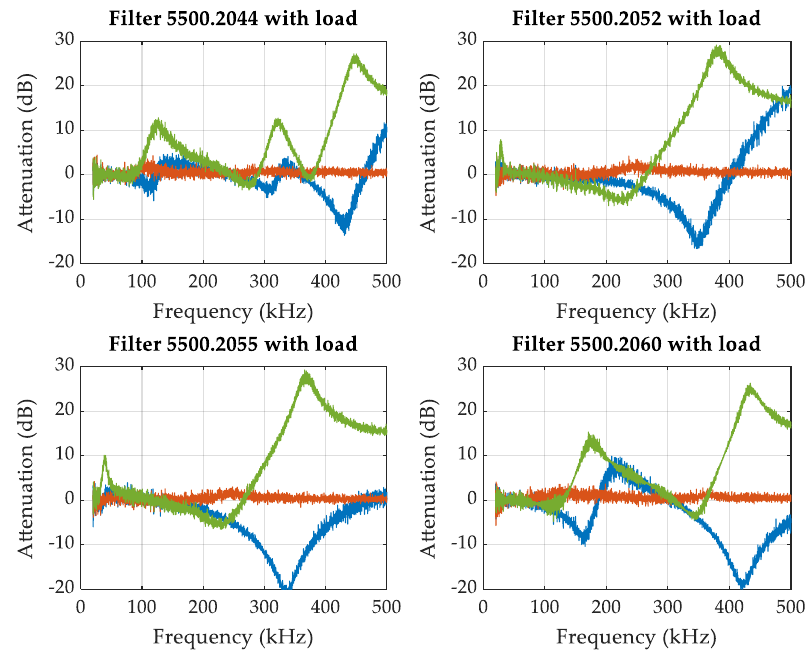
Figure 8. Attenuation due to the EMC filters under study, when a load is connected at ports L’-N’. Blue lines indicate that the filter is connected at point A, red lines indicate connection point B, and green lines indicate connection point C.